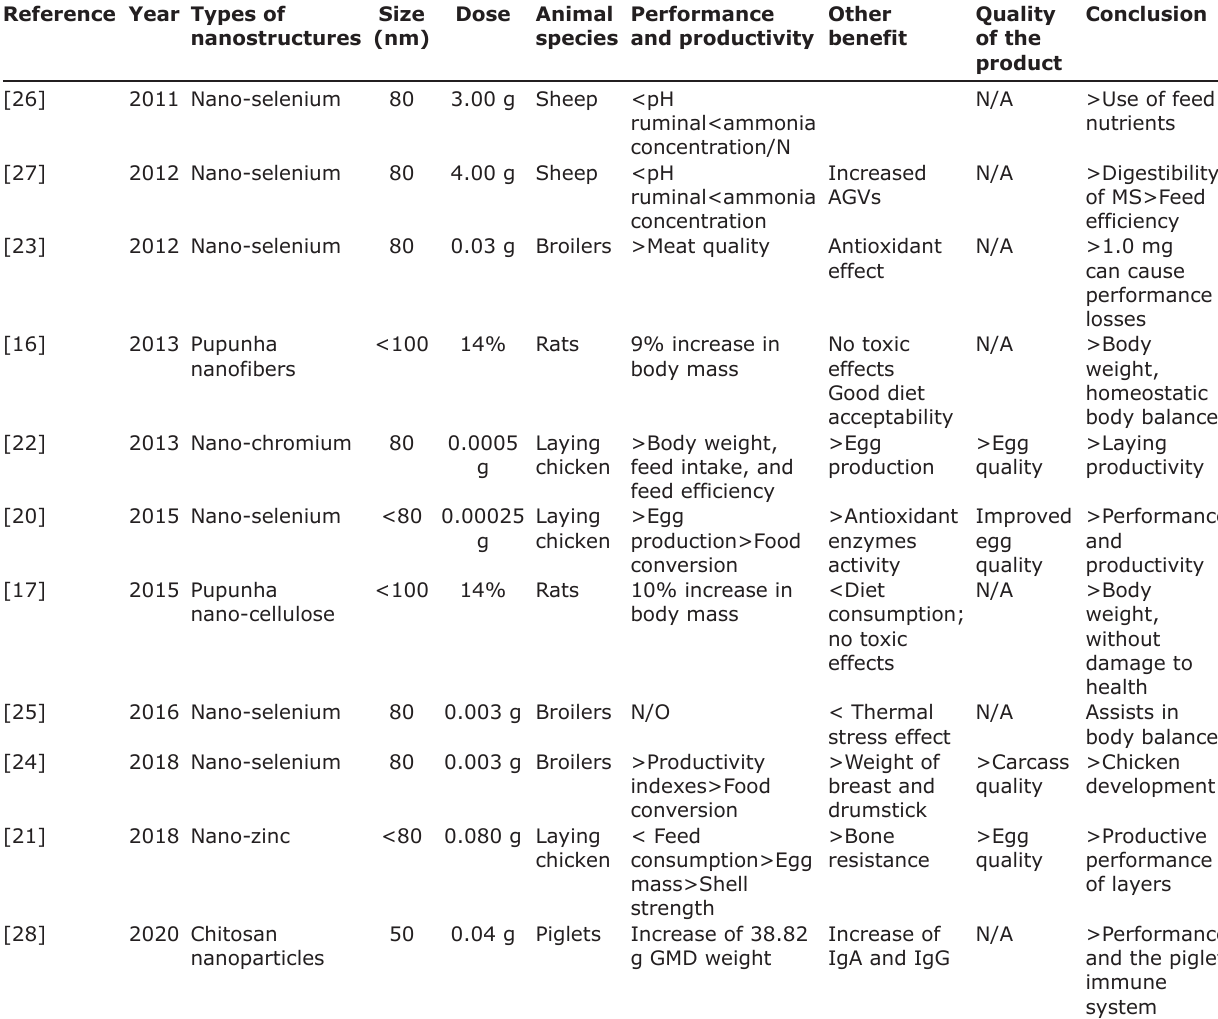
Table-1: Inclusion of nanoparticles in the animal diet as ingredients, and the impacts on animal